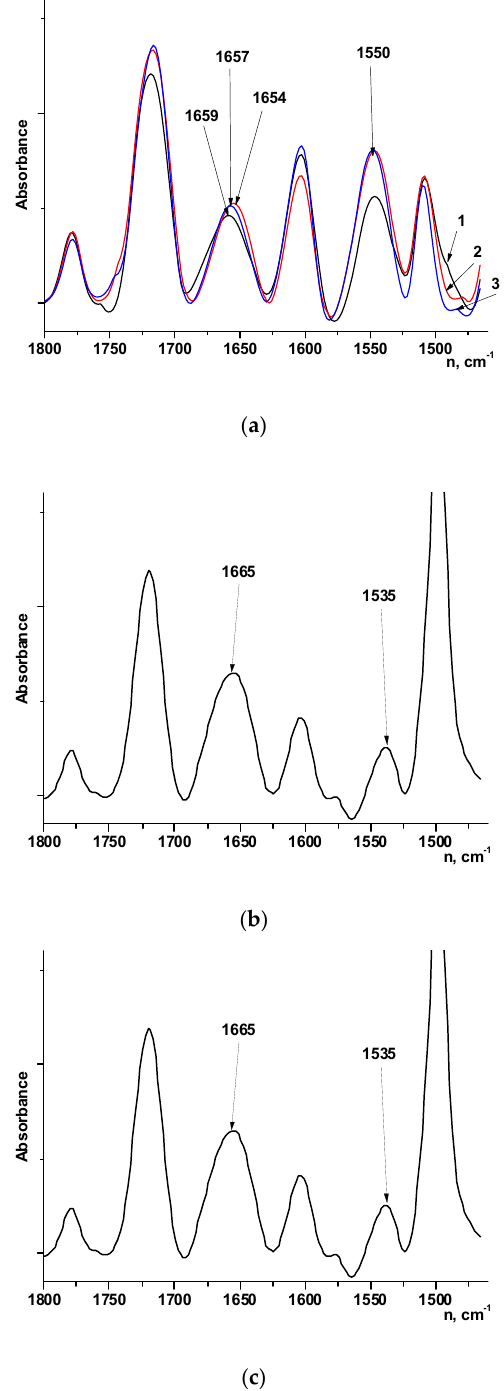
Figure 10. FTIR spectra of ( a ) PAI-2: (1) powder, (2) film, (3) asymmetric membrane; ( b ) PAI-1; ( c ) coPAI-2 (50% DABA): (1) asymmetric membrane, (2) film.